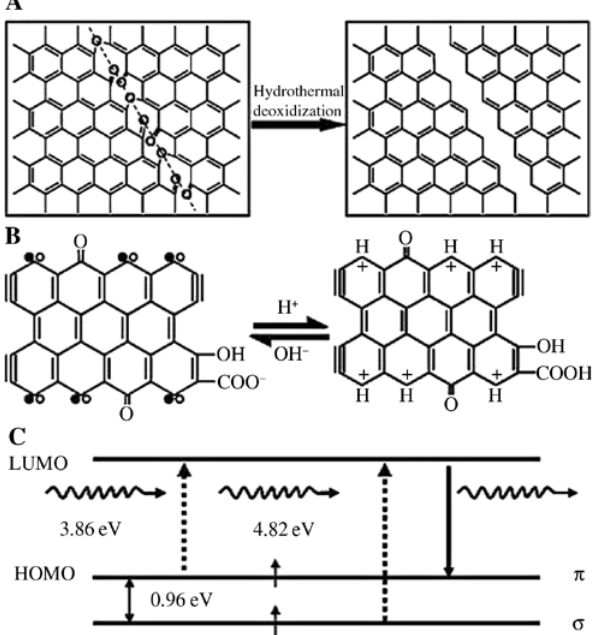
Figure 4: The mechanism for the hydrothermal method and models of the GQDs in acidic and alkali media, as well as typical electronic transitions of triple carbenes at zigzag sites. (A) Mechanism for the hydrothermal cutting of oxidized GSs into GQDs: a mixed epoxy chain composed of epoxy and carbonyl groups (left) is converted into a complete cut (right) under the hydrothermal treatment. B) Models of the GQDs in acidic (right) and alkali (left) media. The two models can be converted reversibly depending on pH. The pairing of σ ( ·) and π (o) localized electrons at carbene-like zigzag sites, and the presence of triple bonds at the carbyne-like armchair sites are represented. (C) Typical electronic transitions of triple carbenes at zigzag sites observed in the optical spectra (reprinted/reproduced with the per- mission of Ref. [68], copyright 2010, Wiley-VCH Verlag GmbH &